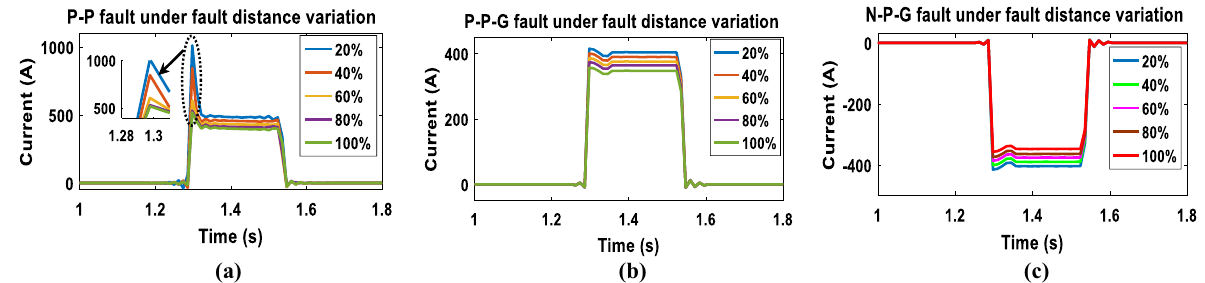
Fig. 7 DC cable faults under fault distance variation a P-P fault, b P-P-G fault, and c N-P-G